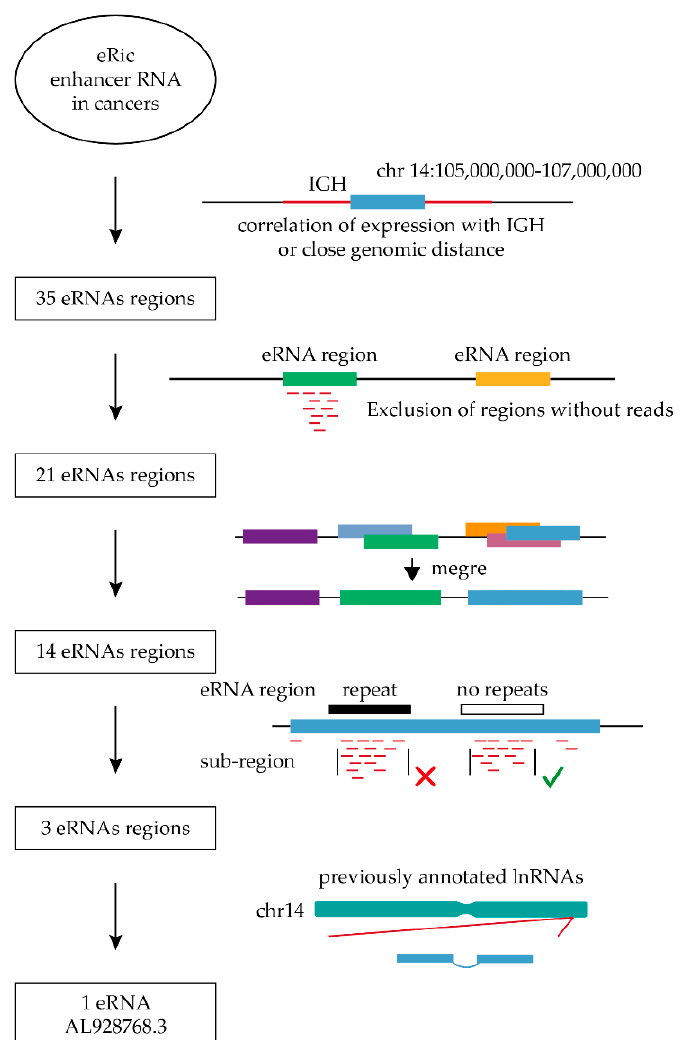
Figure 1. The scheme of the bioinformatics search. The first diagram shows a schematic representation of the IGH locus. The second illustration shows a schematic representation of the alignment and the third diagram presents the regions before and after the merge. The fourth diagram illustrates the identification of sub-regions densely covered with reads followed by the exclusion of sub-regions overlapping with the genomic repeats. Only one region of three has previously annotated lncRNA. The fifth diagram shows schematically chromosome 14 and the region containing